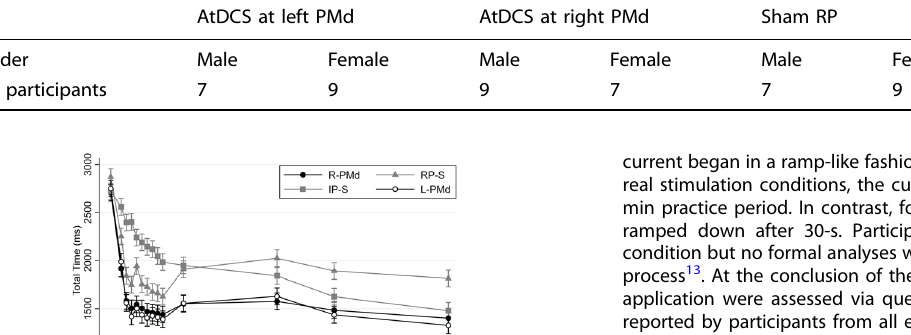
Table 1. Gender and participant distribution to each of the four experimental conditions used in this experiment. AtDCS at left PMd